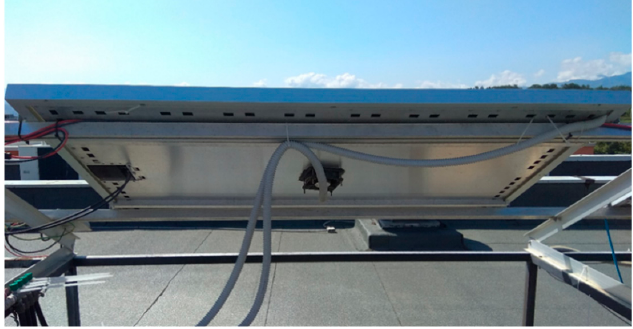
Figure 3. Ventilation system installed on the PV5